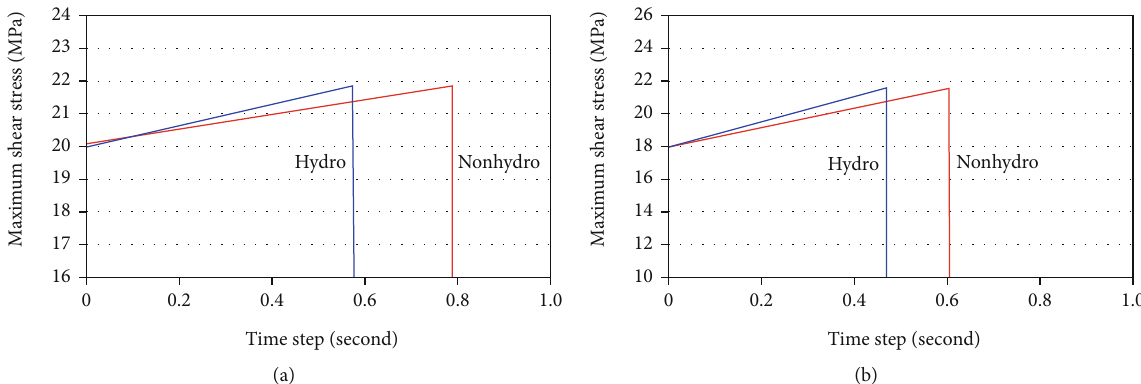
Figure 17: Evolutions of the maximum shear stress under continued mechanical loading: (a) scheme 3 of the strength parameters; (b) scheme 4 of the strength parameters.